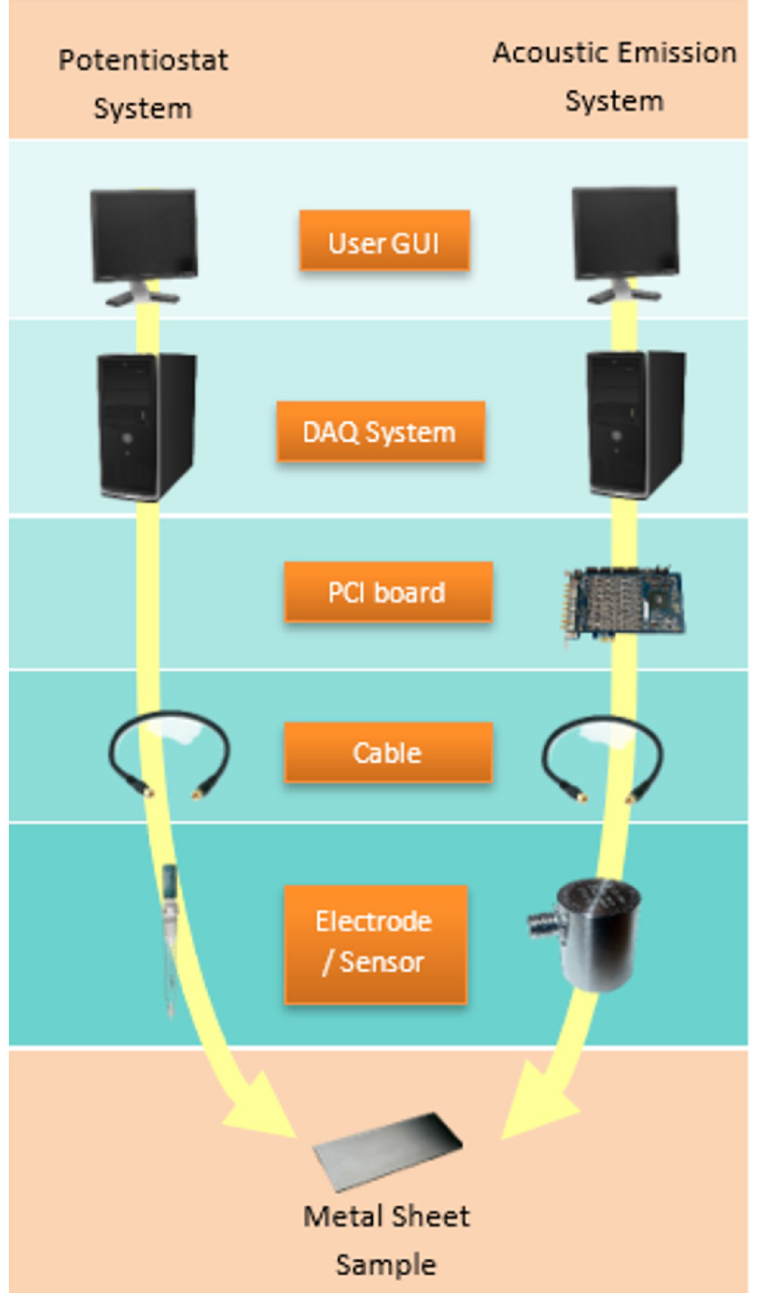
Fig 3. Schematic flow diagram of LPR test during AE data